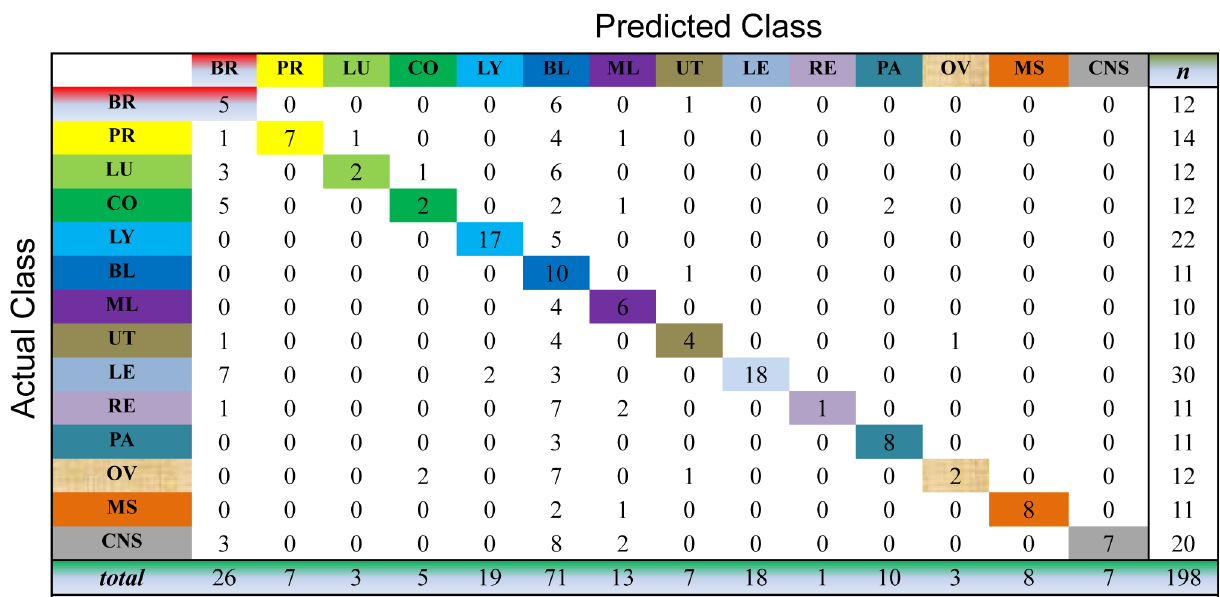
Fig 4. Confusion matrix of prediction results using SCNMF, which achieves a total accuracy of 48.99%. Matrix delineates distribution of actual compared with predicted class membership for multiclass cancer prediction on the GCM